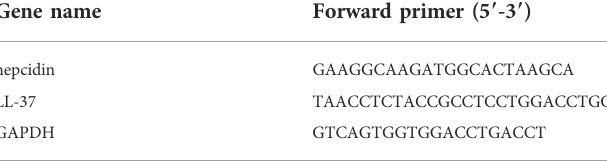
TABLE 1 Sequence of primers used for